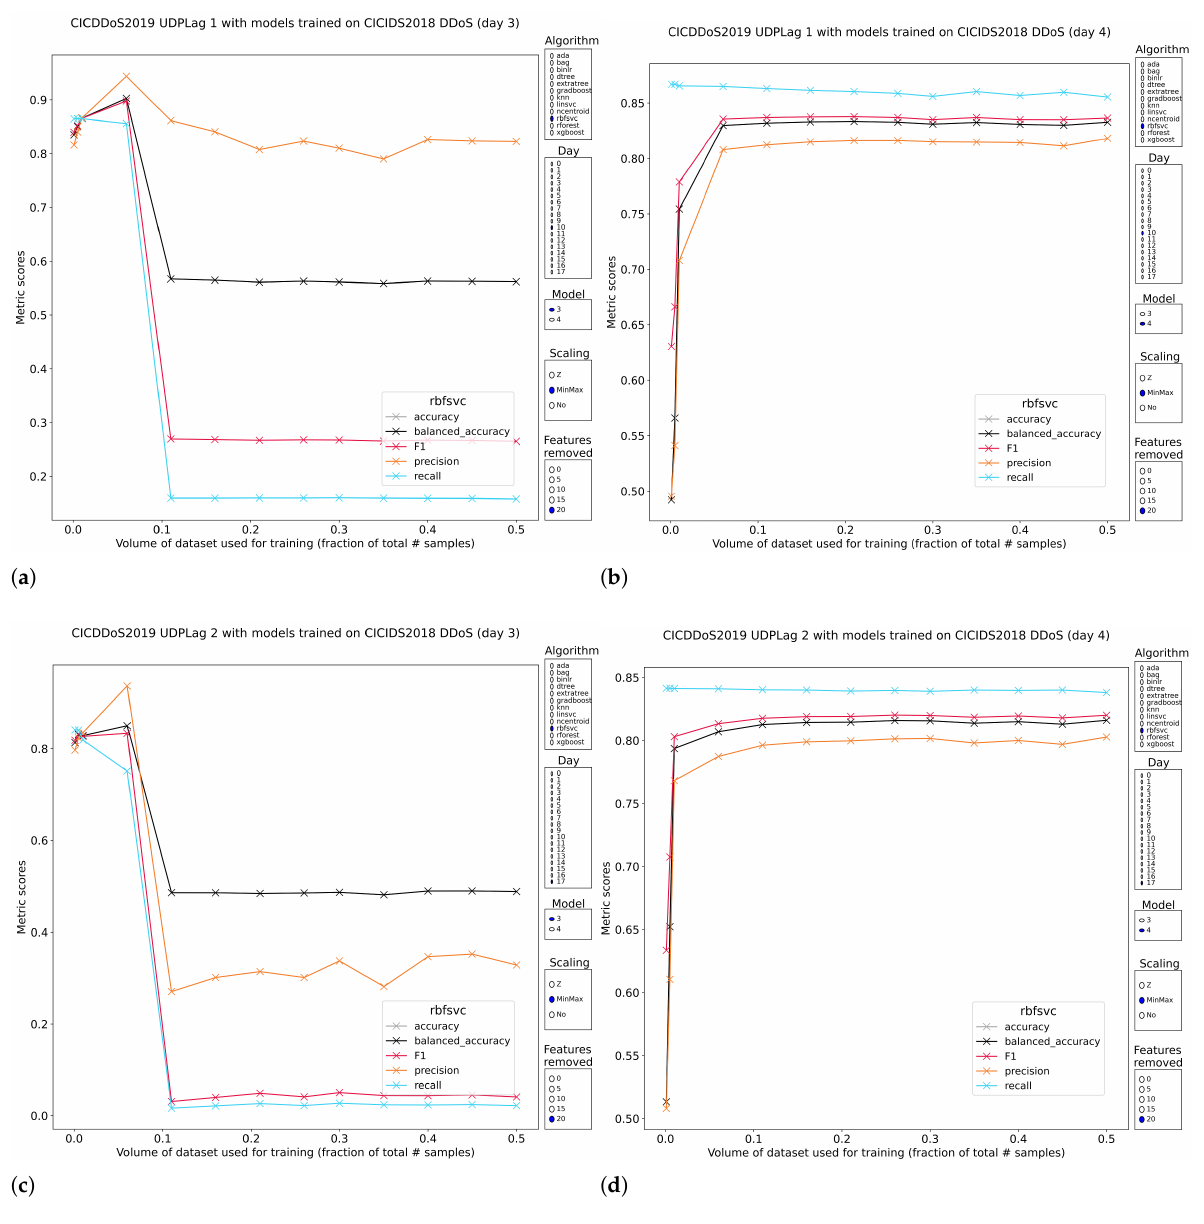
Figure 17. RBF-SVMs pretrained on the available DDoS subsets in CSE-CIC-IDS2018 have signifi- cantly different, but self-consistent general performance profiles on the UDP-lag attack subsets of